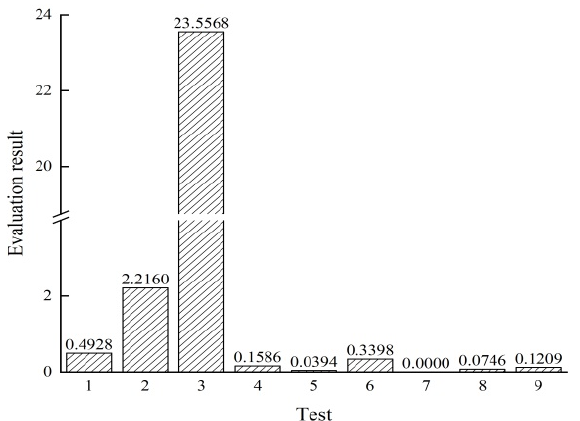
Figure 9. The evaluation results of each test.